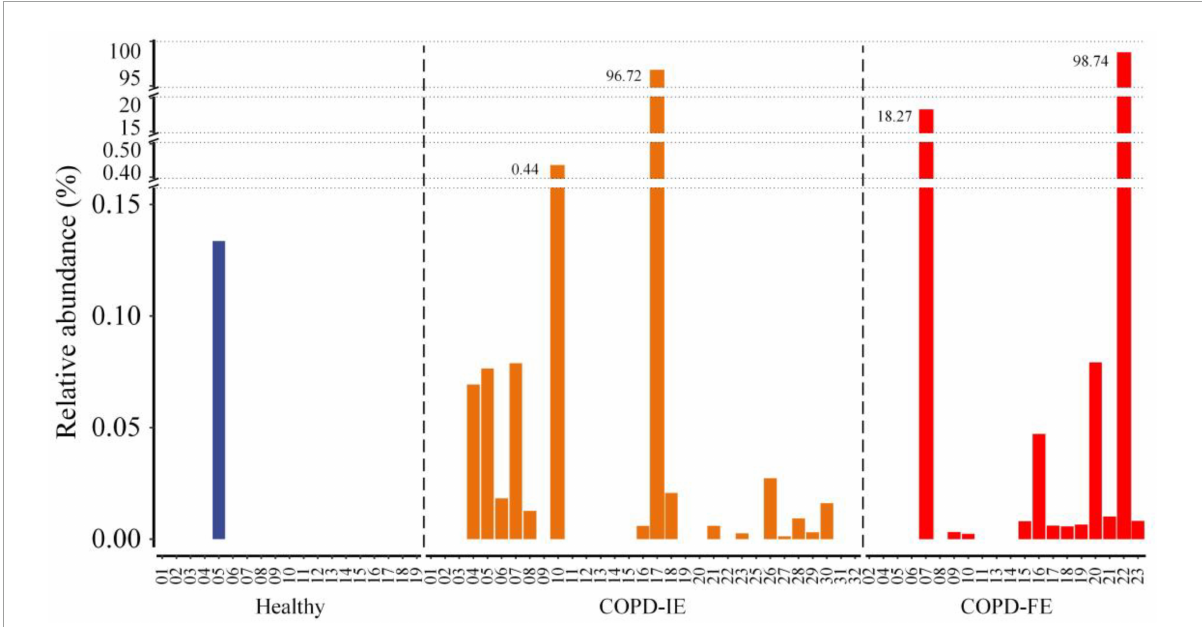
FIGURE6 The frequency and relative abundance of the Stenotrephomonas in healthy controls, chronic obstructive pulmonary disease with infrequent exacerbations (COPD-IE), and COPD with frequent exacerbations